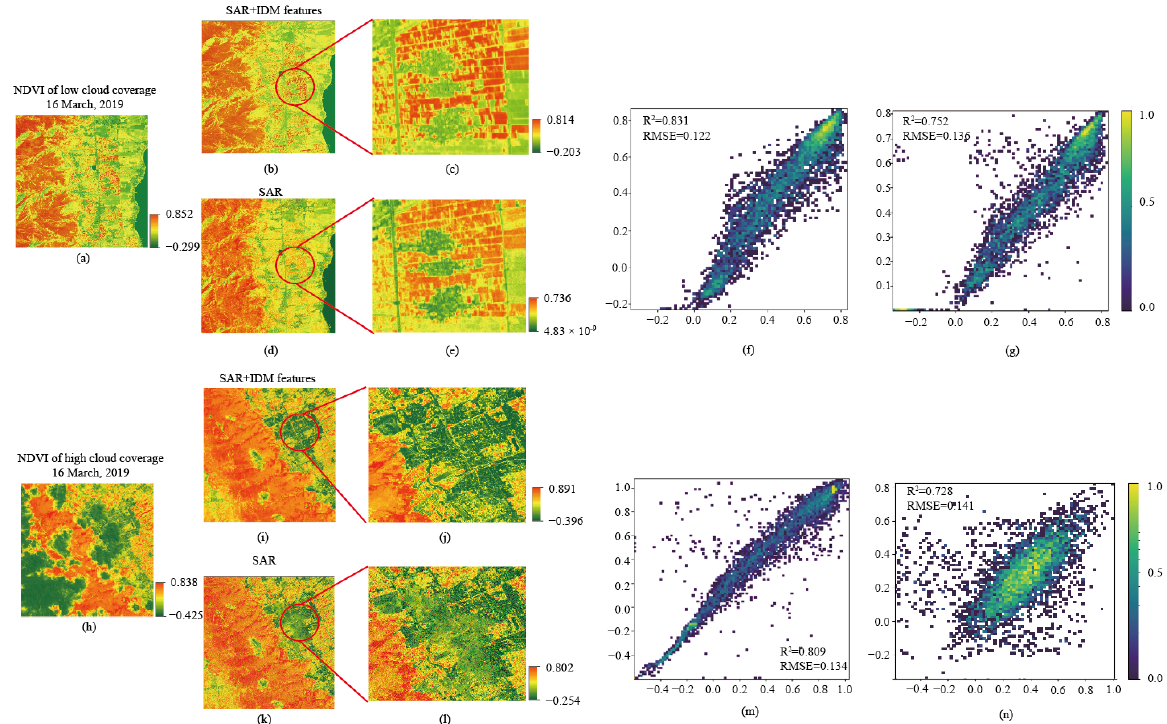
Figure 10. The NDVI retrieval results of the double-attention RNN with and without IDM features; ( a , h ) show the NDVI images with low and high cloud coverage conditions; ( b , d , i , k ) are the retrieval results of the ablation experiment; ( c , e , j , l ) are detailed views of the same region; ( f , m ) are the generated density plots of double-attention RNN; ( g , n ) are density plots of the ablation model. The NDVI images are colorized with diverging colormaps, as in Figure 7; the density plots are depicted in viridis.